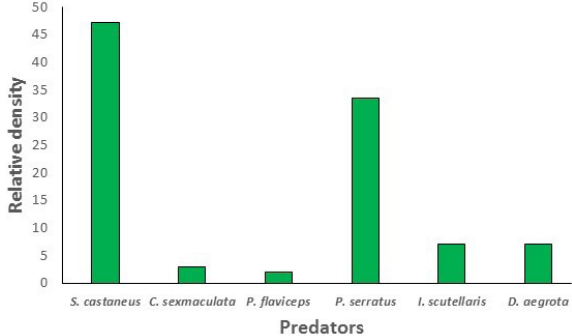
Figure 1. Relative density of aphidophagous predators of cashew